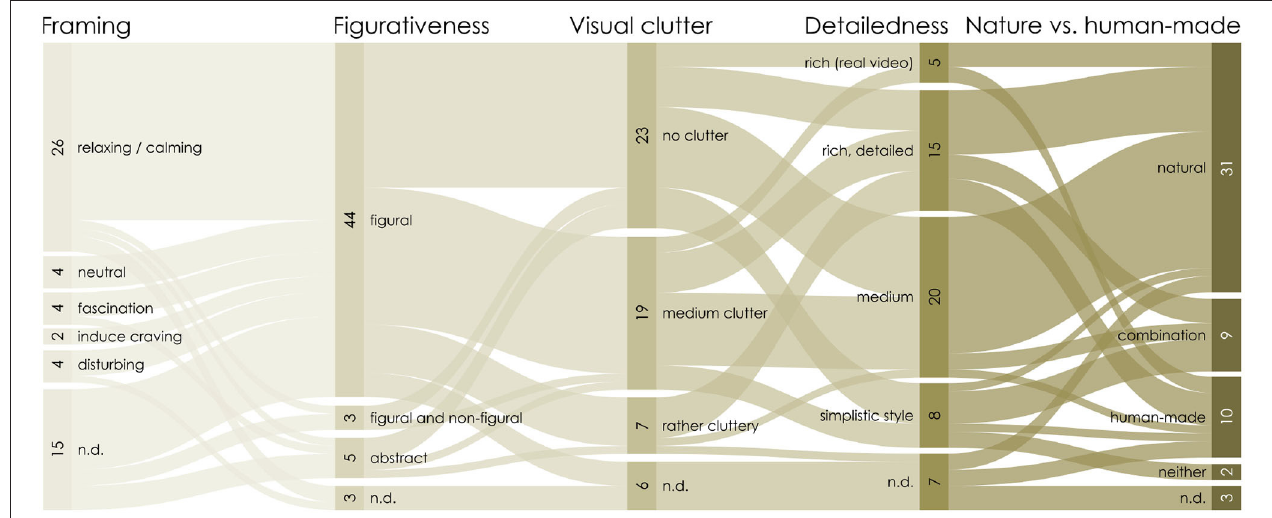
FIGURE 2 | Depiction of the different attributes of virtual environments used in the literature on XR-based mindfulness support. As some papers included different versions of virtual environments, the numbers here do not match the total number of papers.